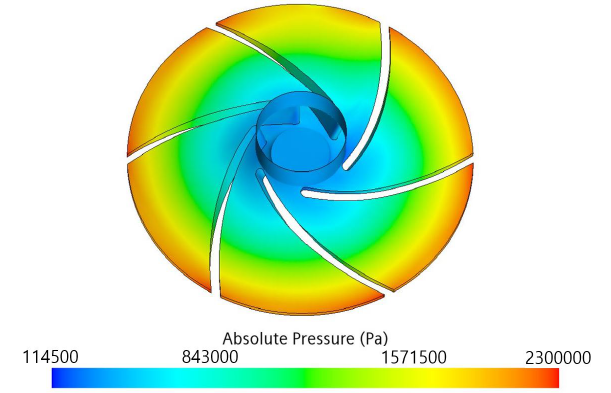
Figure 10. Impeller pressure